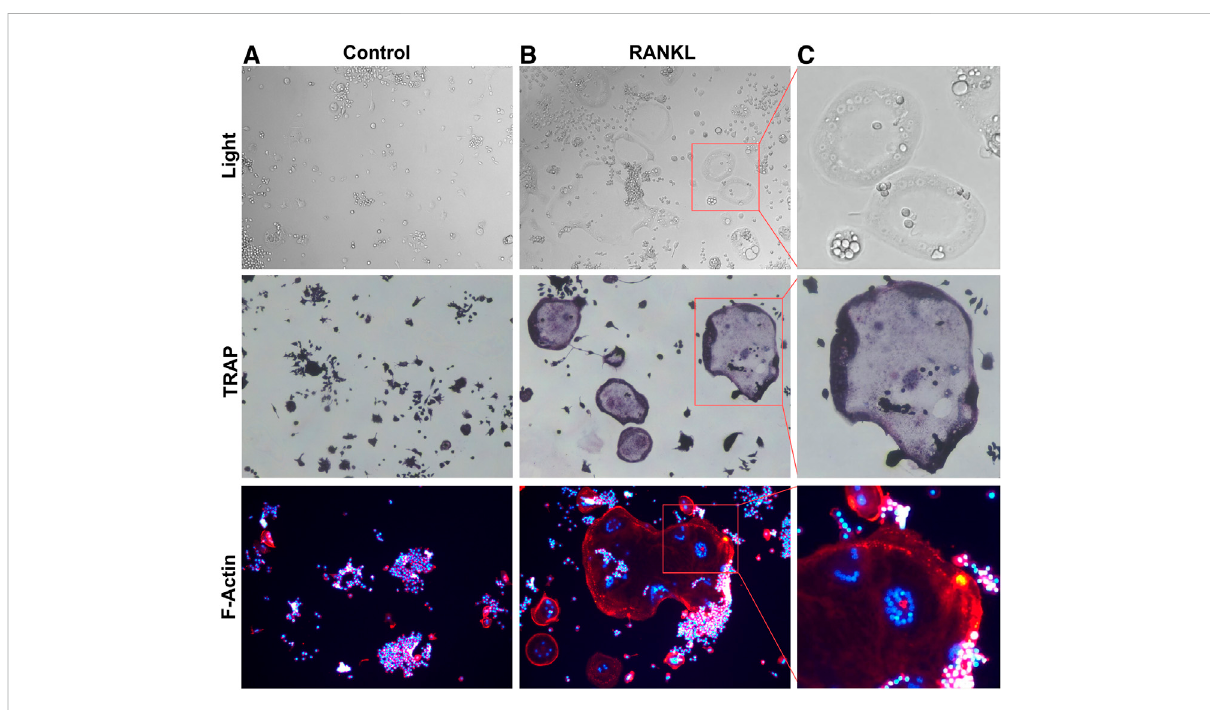
FIGURE 1 RANKL induced Osteoclastogenesis (A) . RAW264.7 cells were not stimulated by RANKL. (B) . RANKL-stimulated RAW264.7 cells differentiation into multinucleated osteoclasts. (C) . Box magni fi ed of